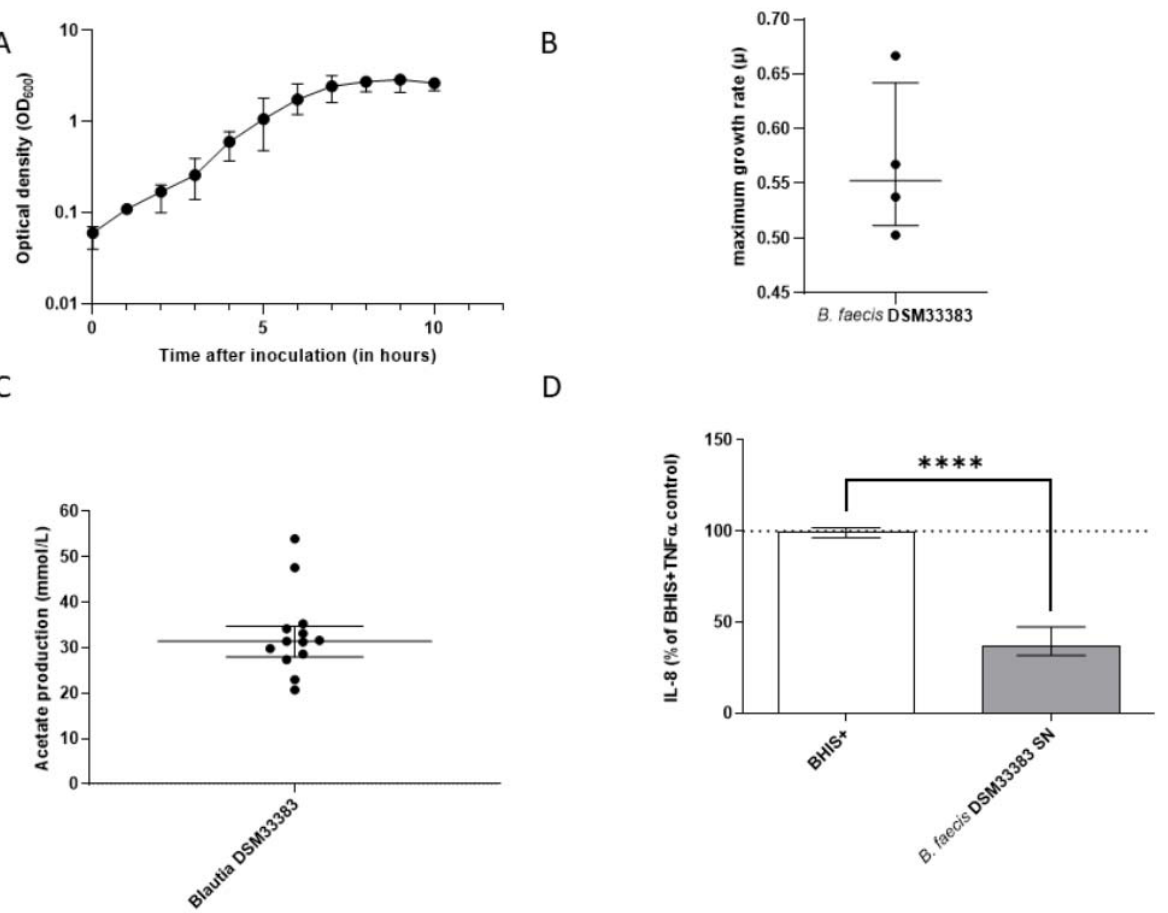
Figure 3. Growth characteristics of B. faecis DSM33383 in BHIS+ medium and in vitro anti-inflammatory effect. ( A ) Kinetic curve of B. faecis DSM33383 grown in BHIS+. Logarithmic representation of the OD at 600 nanometers (nm), taken with one ‐ hour intervals. n = 4. Median with interquartile range (IQR). ( B ) Maximum growth rates ( μ ) of the selected growth curves. n =4. Median with interquartile range (IQR). ( C ) Acetate production in mM by B. faecis DSM33383, sampled in the stationary phase. Acetate levels of each sample were normalized with the acetate level of the BHIS+ medium without bacteria. n = 13 for B. faecis DSM33383. Median with interquartile range (IQR). ( D ) The IL ‐ 8 response of TNF α stimulated HT ‐ 29 cells supplemented with the culture supernatant (SN) (25%) of either B. faecis DSM33383 compared to the control with 25% BHIS+. n = 6 Median with interquartile range (IQR). **** p < 0.0001.